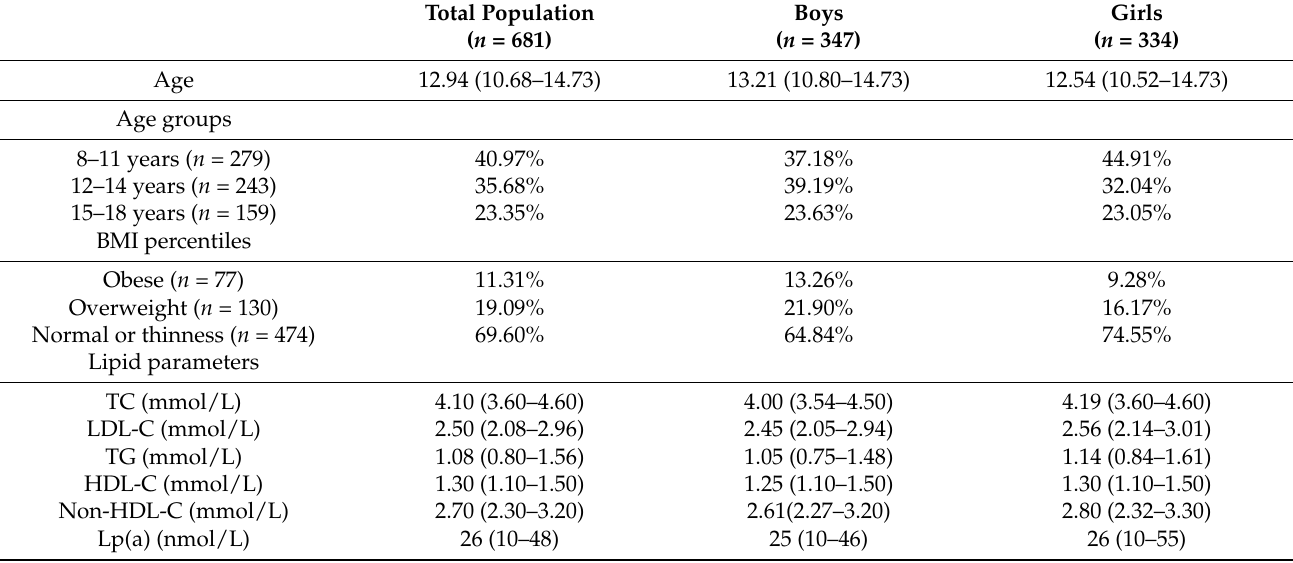
Table 1. Baseline demographic, BMI percentile, and lipid parameters of the total population, and boys and girls when taken separately. Categorical variables are expressed as percentages and non-normal continuous variables are expressed as Median with its interquartile ranges (1st quartile–3rd